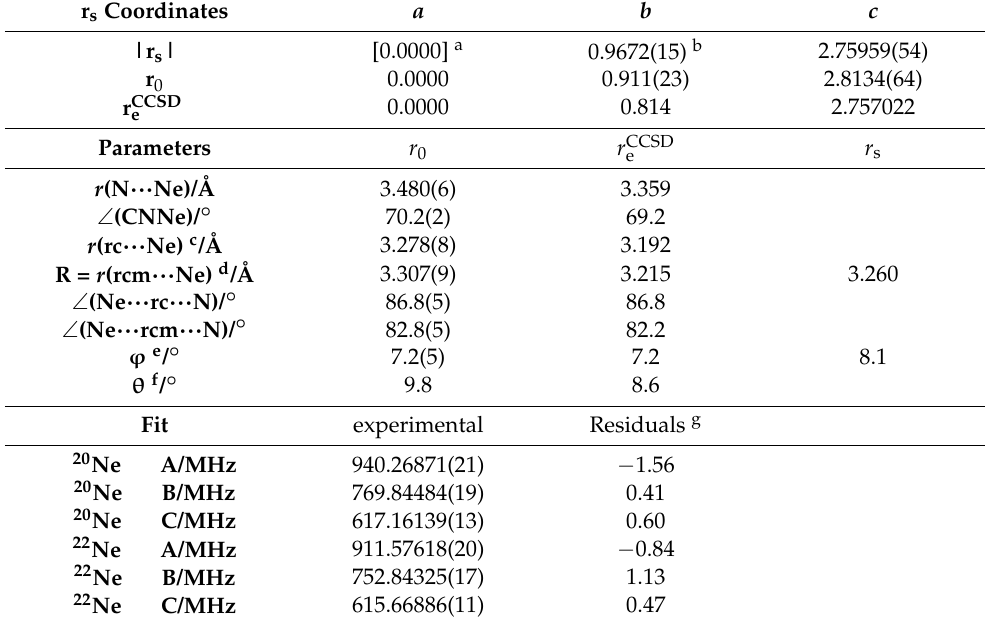
Table 3. Principal inertial axis coordinates for the neon atom of pentafluoropyridine ··· Ne complex. The table compares the substitution ( r s ) and effective ( r 0 ) coordinates with those ( r e ) calculated at the CCSD/6-311++G(2d,p) (CCSD) computational methods. The table also compares the effective bonding parameters determined from a least-squares fit of the observed rotational constants, and the angle θ of rotation between the principal inertial axis systems of F 5 PY and F 5 PY-Ne. r s Coordinates a b c |r s | [0.0000] a 0.9672(15)